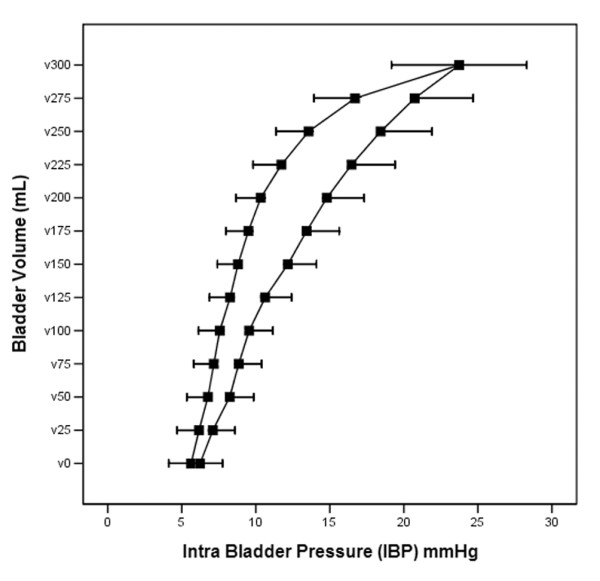
Curve fit of the mean intra-bladder pressures (IBPs) on the X-axis versus the instilled bladder volume (Y-axis) from all patients. The 'inflation' (right-hand side) and 'deflation' (left hand side) pressure volume (PV) curve is plotted as a curve fit of the means of the 30 measurements. Hysteresis can be seen, as with respiratory PV curves. No clear lower inflection point can be identified; via extrapolation, an upper inflection point was found at a bladder volume of 150 ml to 175 ml on the inflation limb. Error bars show 95% confidence intervals.